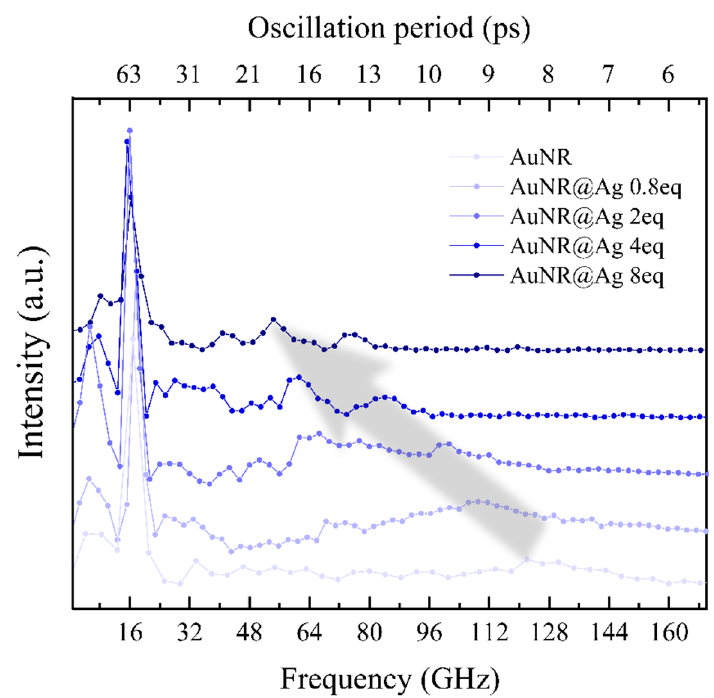
Figure 3. FFT spectra of the TA signals of bare AuNRs and AuNR@Ag NPs probed in their respective LgSPR ( L 0 ) mode domains. The spectra show the intensity of the oscillations in arbitrary units as a function of both their frequency (bottom axis) and period (top axis). The curves have been ver- tically shifted from each other for sake of clarity. The shadow arrow highlights the frequency shift in the high-frequency vibration modes with increasing the silver amount.